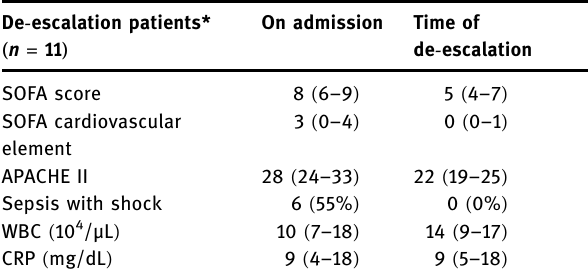
Table 3: Comparison of characteristics at baseline vs time of de - escalation ( de - escalation patients